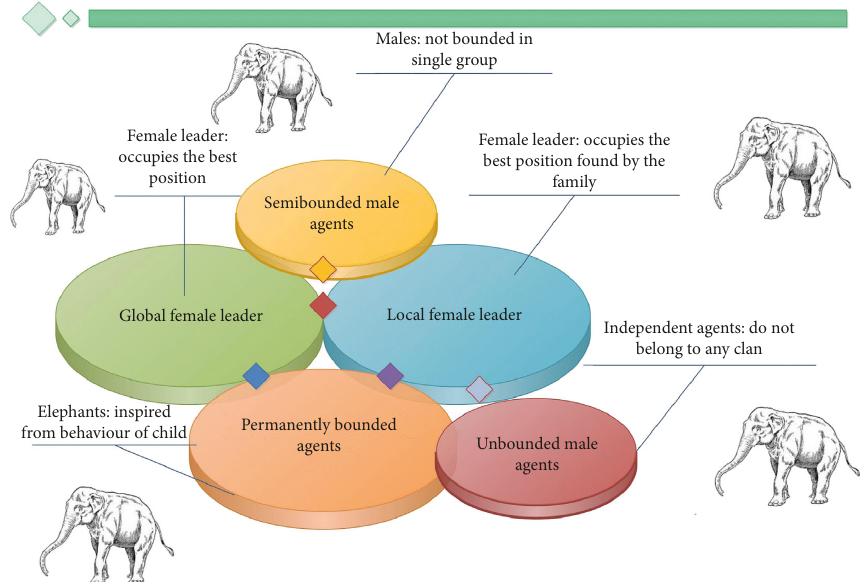
Figure 1: Structured clanning-based ensemble optimization